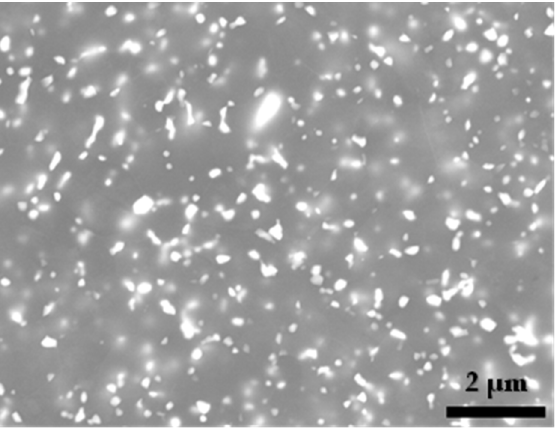
Figure 1. Microstructure of the uncorroded sample with the magnesium matrix and Y, Nd rich precipitates.